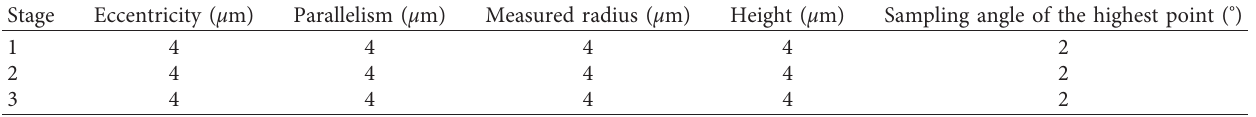
Table 5: The tolerance values of the geometric parameters of the rotors at diverse stages.